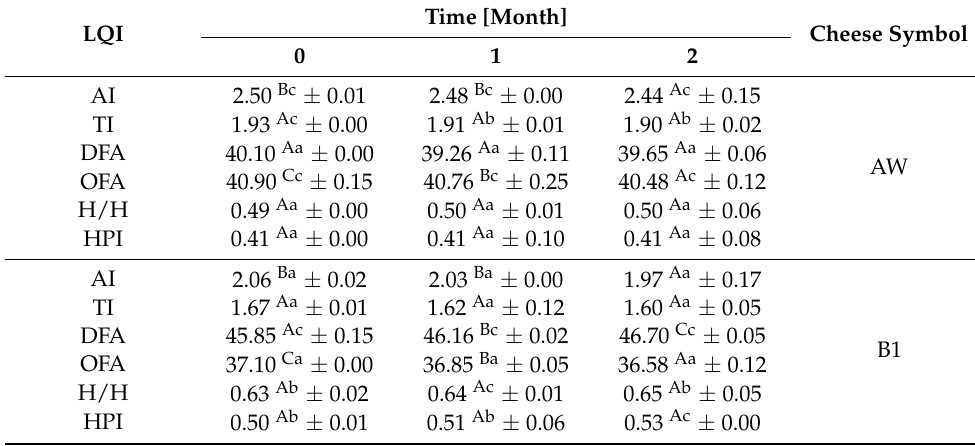
Table A2. The Lipid Quality Indices of goat’s cheeses after production and after 1 and 2 months of